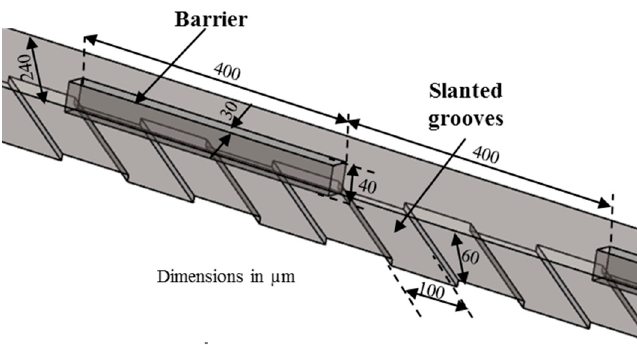
Figure 8. Barrier embedded chaotic micromixer: M-8 (no. of mixing units used: 6) [58].